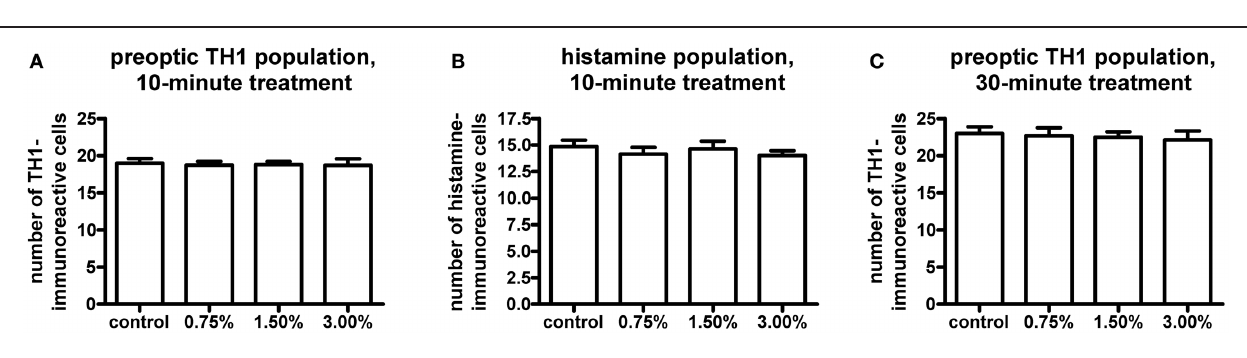
FIGURE 4 | Cell numbers in the histaminergic and preoptic dopaminergic populations after the ethanol treatment. A 10-min ethanol treatment had no effect on either population. In order to see if any change was occurring after a longer treatment, the preoptic dopaminergic population was further analysed after a 30-min treatment.